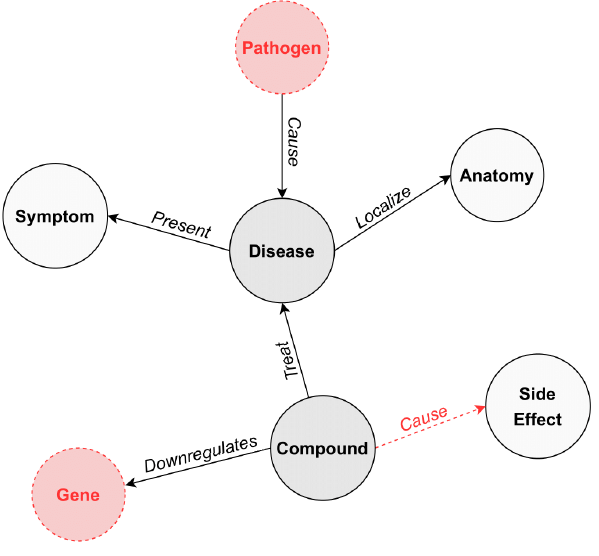
Figure 1. Example of link prediction with a missing head ( ? , Cause , Disease ), tail ( Compound , Down- grades , ? ), and relation ( Compound , ? , Side Effect ). Red components denote potential relationships that may extend the knowledge graph